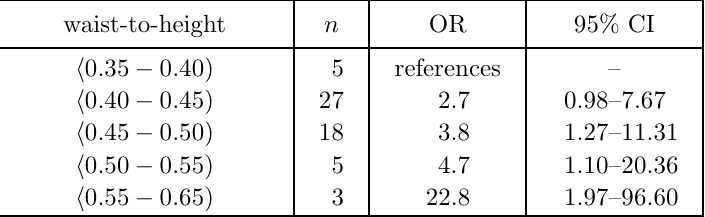
Table 3. Odds ratio for waist-to-height-ratio for boys waist-to-height n